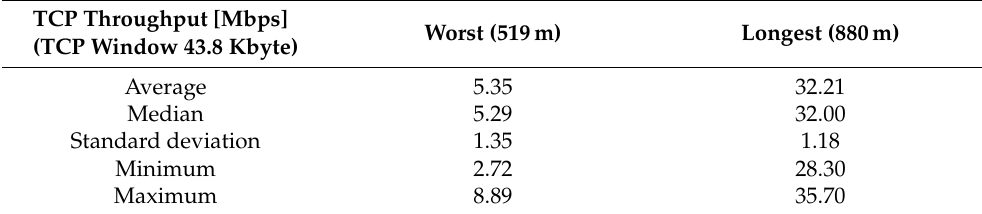
Table 3. TCP throughput the worst vs. the